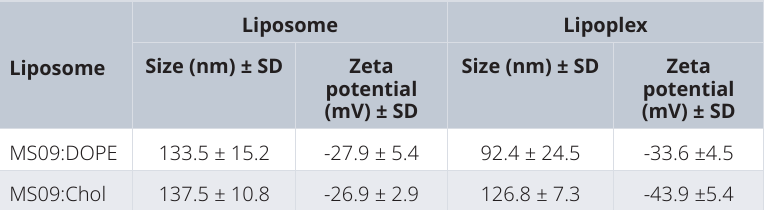
Table 3. Particle sizes and zeta potentials of MS09 liposomal formulations and lipoplexes with siRNA at 16:1 ( w /